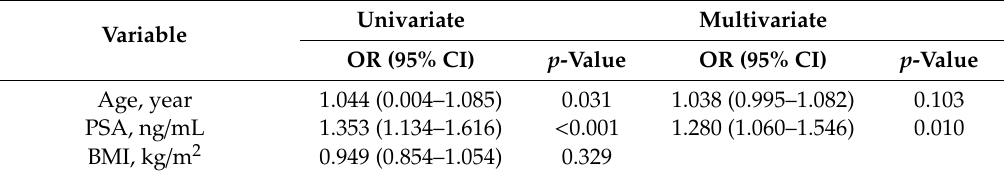
Table 3. Univariate and multivariate analyses of factors associated with the pathologic Gleason score